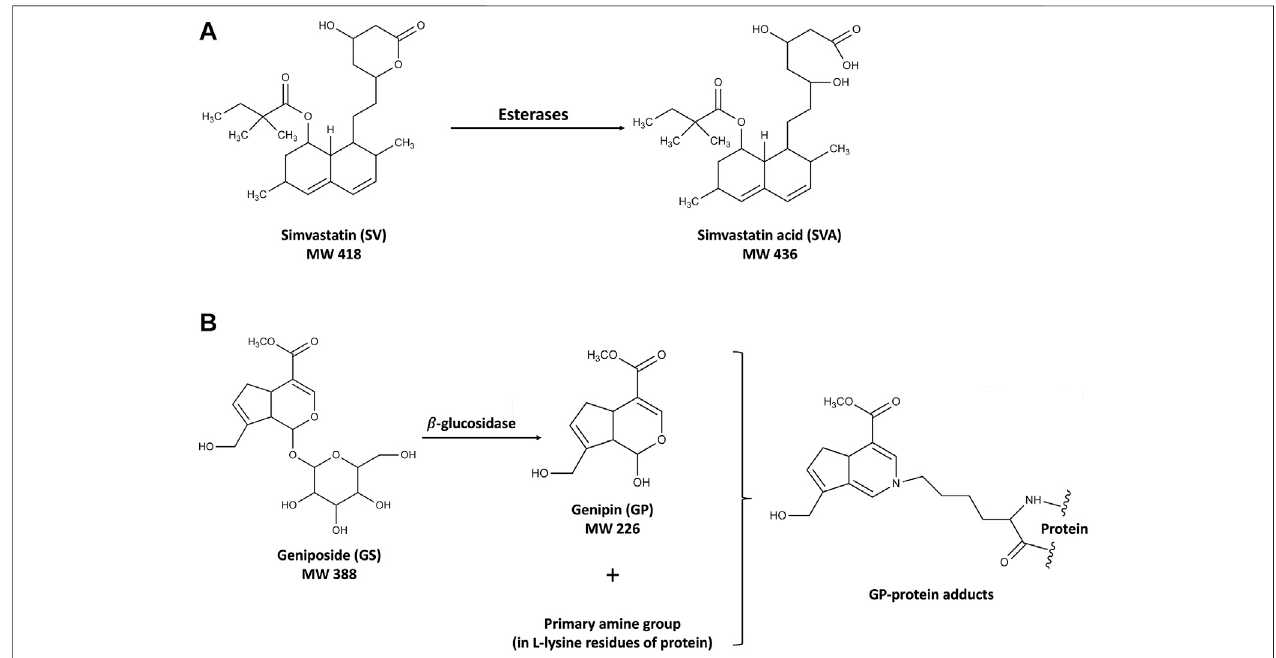
FIGURE 1 | Structures of SV and SVA (A) and the mechanism of the hepatotoxicity induced by GS and GP (B) .